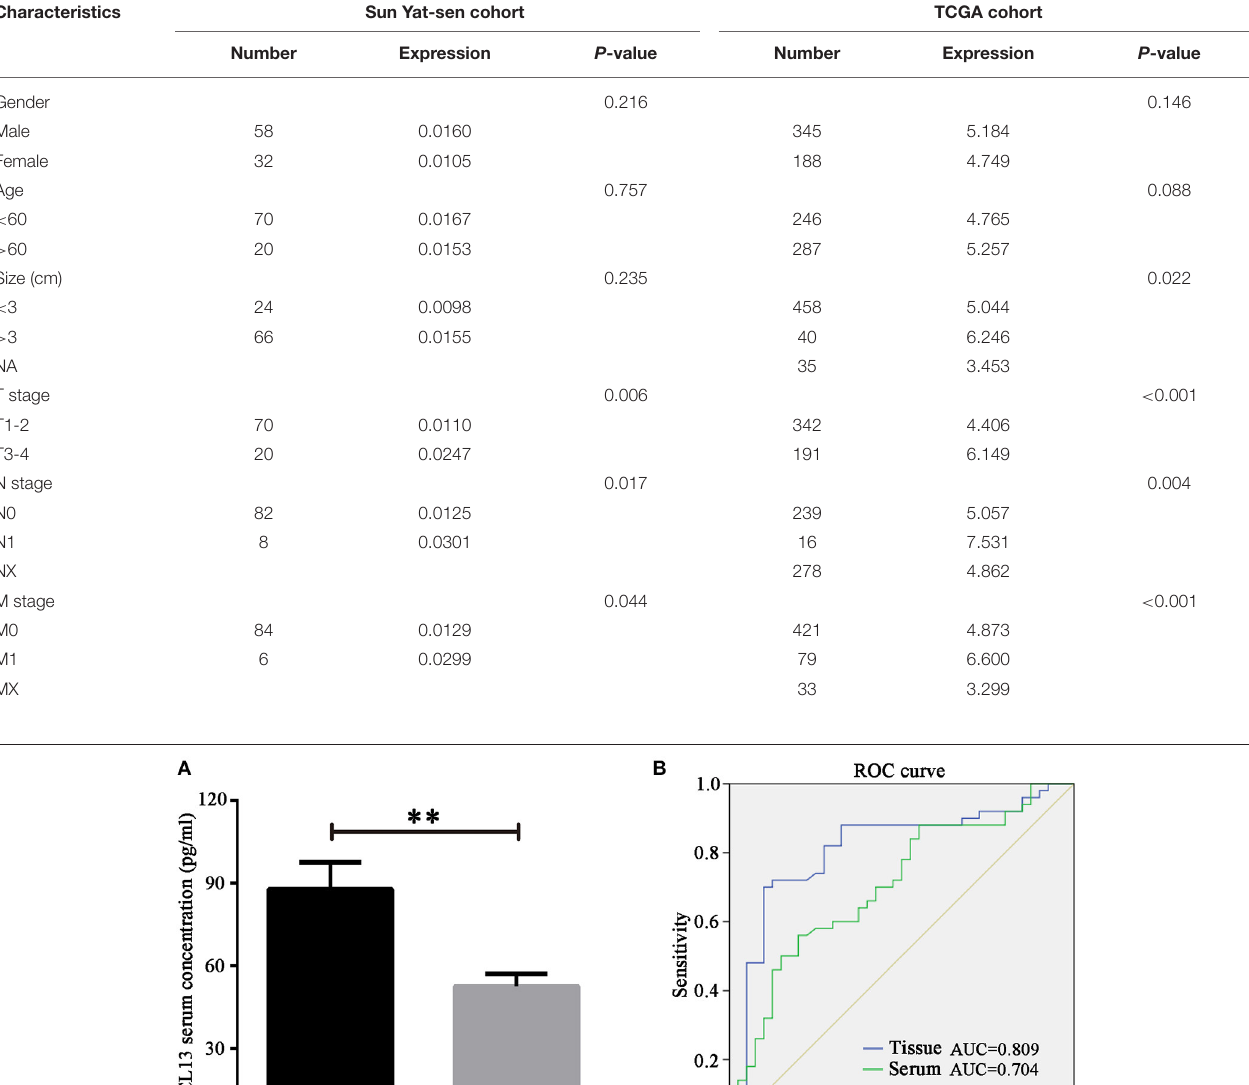
TABLE 1 | Correlation between CXCL13 expression and clinical characteristics of ccRCC Patients. Characteristics